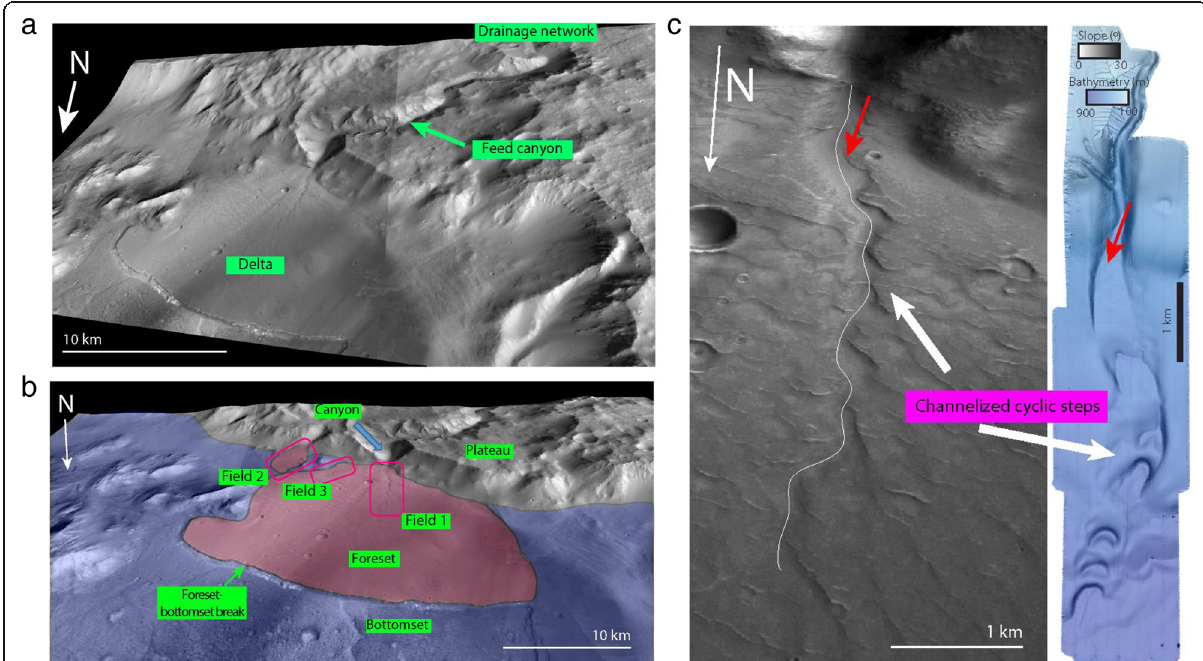
Fig. 10 Newly documented submarine cyclic steps on Mars. A compilation of HiRISE and CTX images shows a extensive valley network draining water into the feeder canyon and Aeolis Mensae Delta, b fields of cyclic steps on the upper foreset deposit of this delta, and c a close-up of field 1 of channelized cyclic steps along the Aeolis Mensae Channel (left) in comparison to San Mateo channelized cyclic steps (right). The white line (left) loosely follows the right side of the Aeolis Mensae